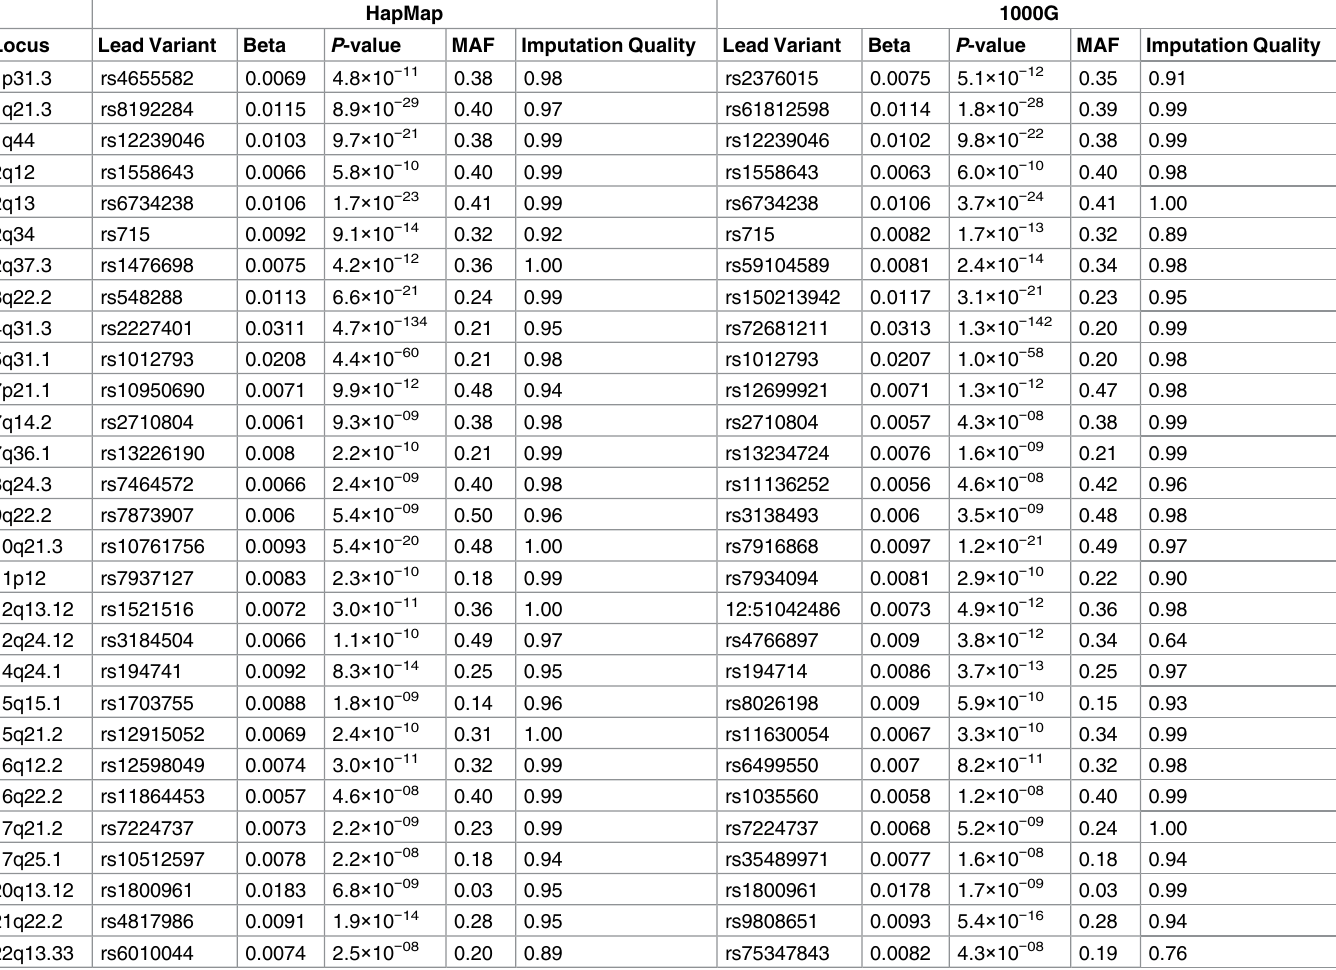
Table 2. Overlapping loci that were significant in both the HapMap and 1000G GWA